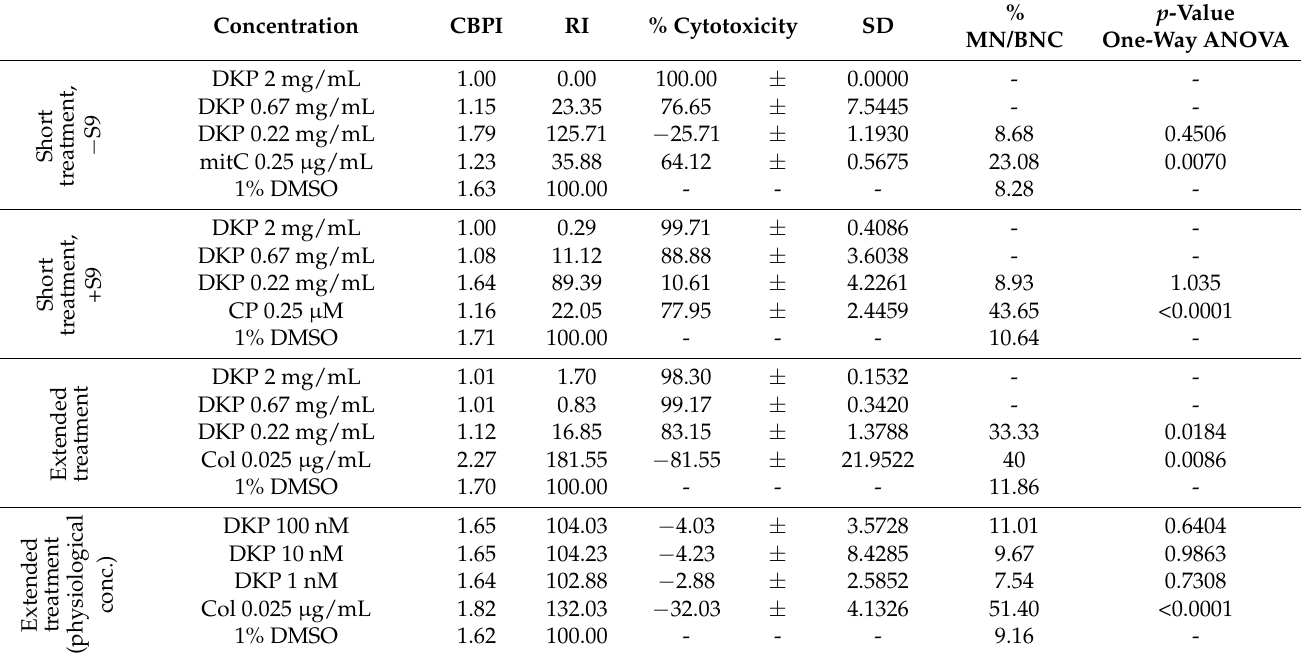
Table 4. Cytostatic effect of DKP indicated by RI (Replication Index) and CBPI (Cytokinesis-Block Proliferation